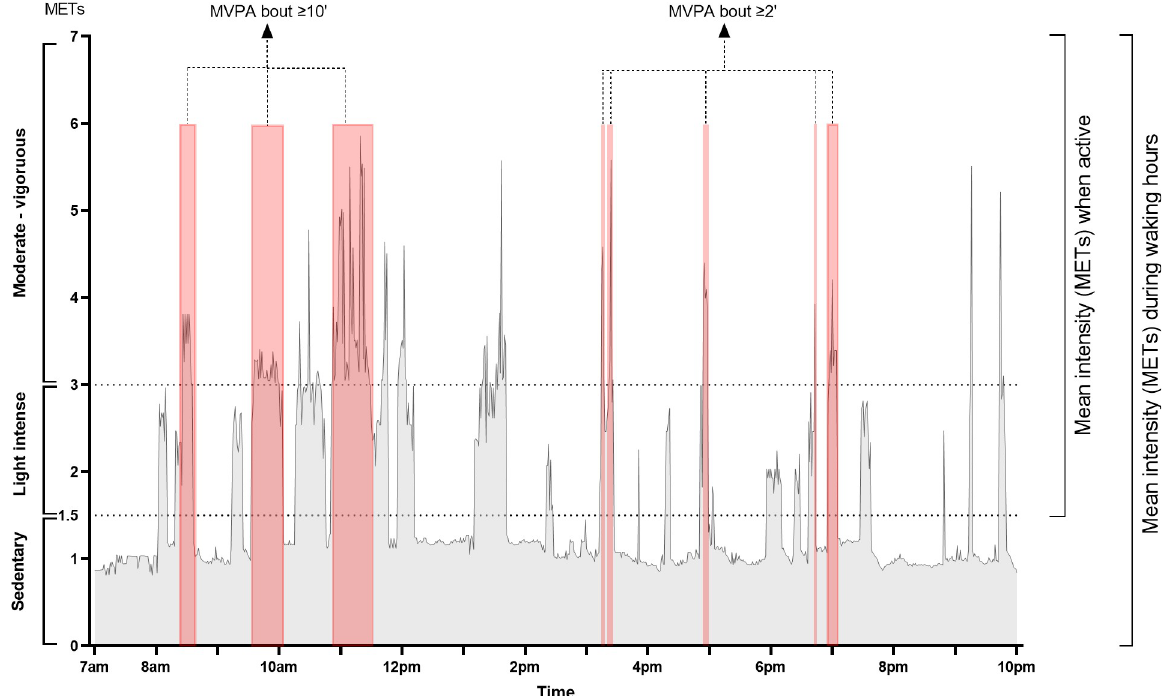
Fig 1. Example of a physical activity report of one day. Example of a physical activity report of one day, measured by SenseWear Pro armband. Mean intensity (METs) during waking hours : mean energy expenditure expressed in metabolic equivalent of a task between 7AM until 10PM. Mean intensity (METs) when active : mean energy expenditure expressed in METs when METs level of 1.5 is exceeded. MVPA bout � 2’ : period of at least two minutes when METs level � 3. Total time MVPA per day is the summation of these periods in one day. MVPA bout � 2’ is also used to calculate the mean duration of a MVPA bout. MVPA bout � 10’ : period of at least 10 minutes when METS level �